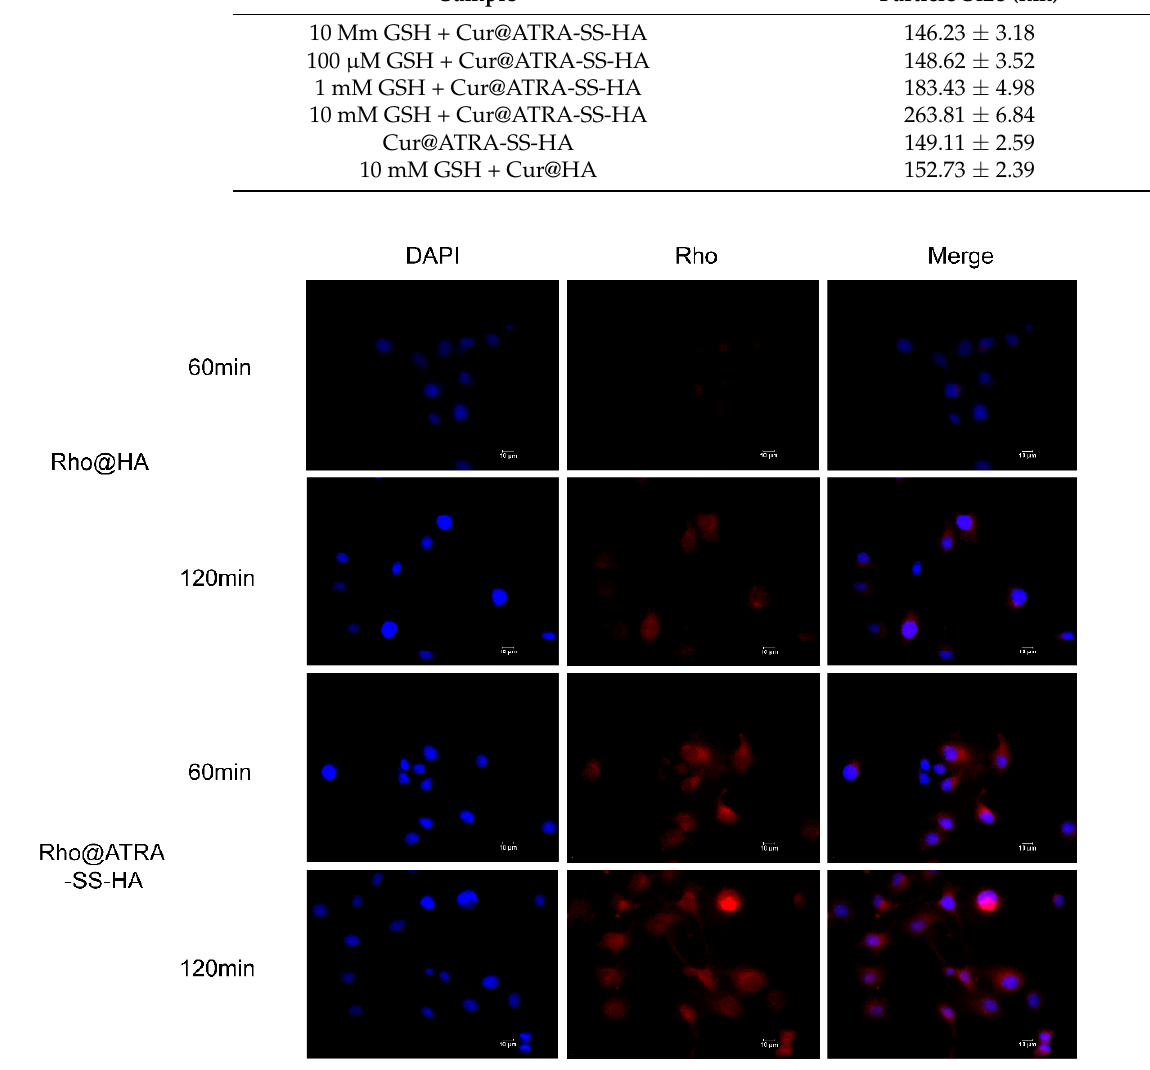
Figure 4. Eca-109 esophageal cancer cells were incubated with Rho@HA and Rho@ATRA-SS-HA for 60 min and 120 min. Images of DAPI and Rhodamine were taken by fluorescence microscope. Scale bar was 10 μ m.